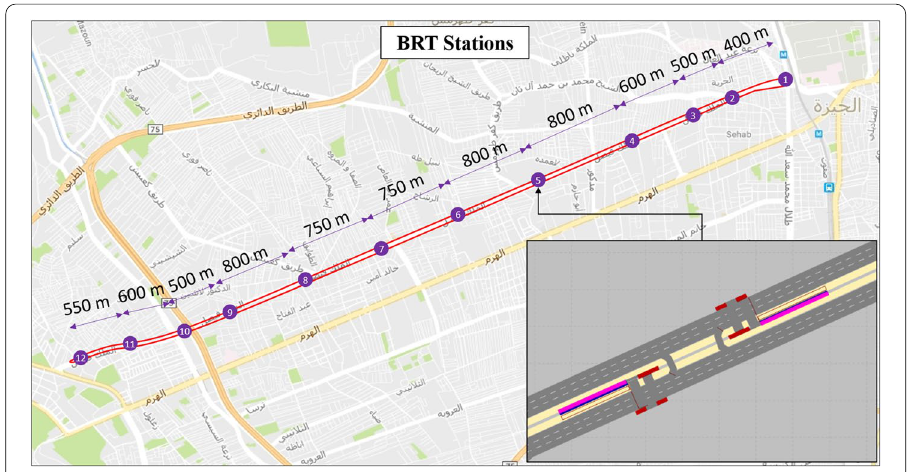
Fig. 4 Locations of the BRT